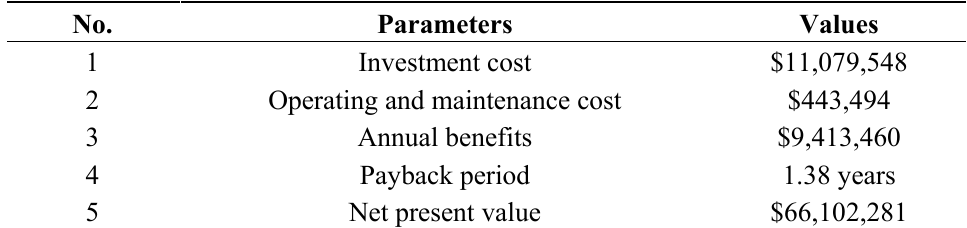
Table 5. Economic analysis of tri-generation